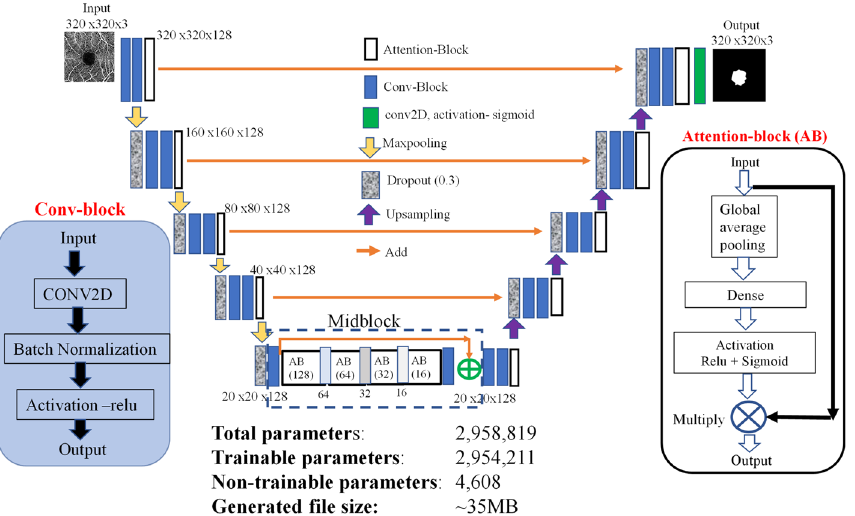
Figure 1. Architecture of a lightweight Deep Learning model (LWBNA_Unet) developed in present study for the segmentation of ophthalmic